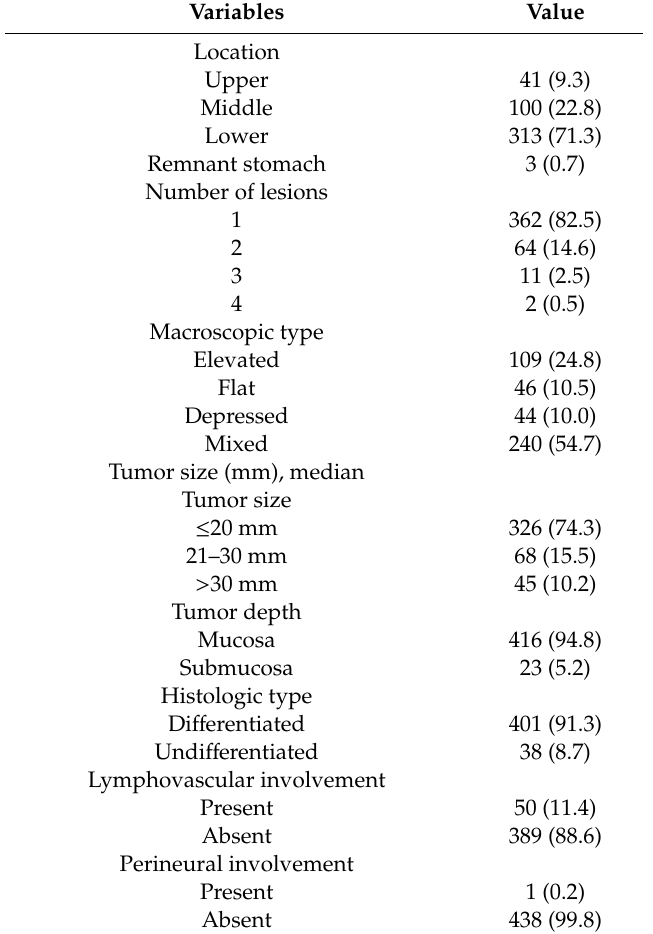
Table 2. Characteristics of the 531 EGCs in the 439 patients aged ≥ 75 years treated by ESD.